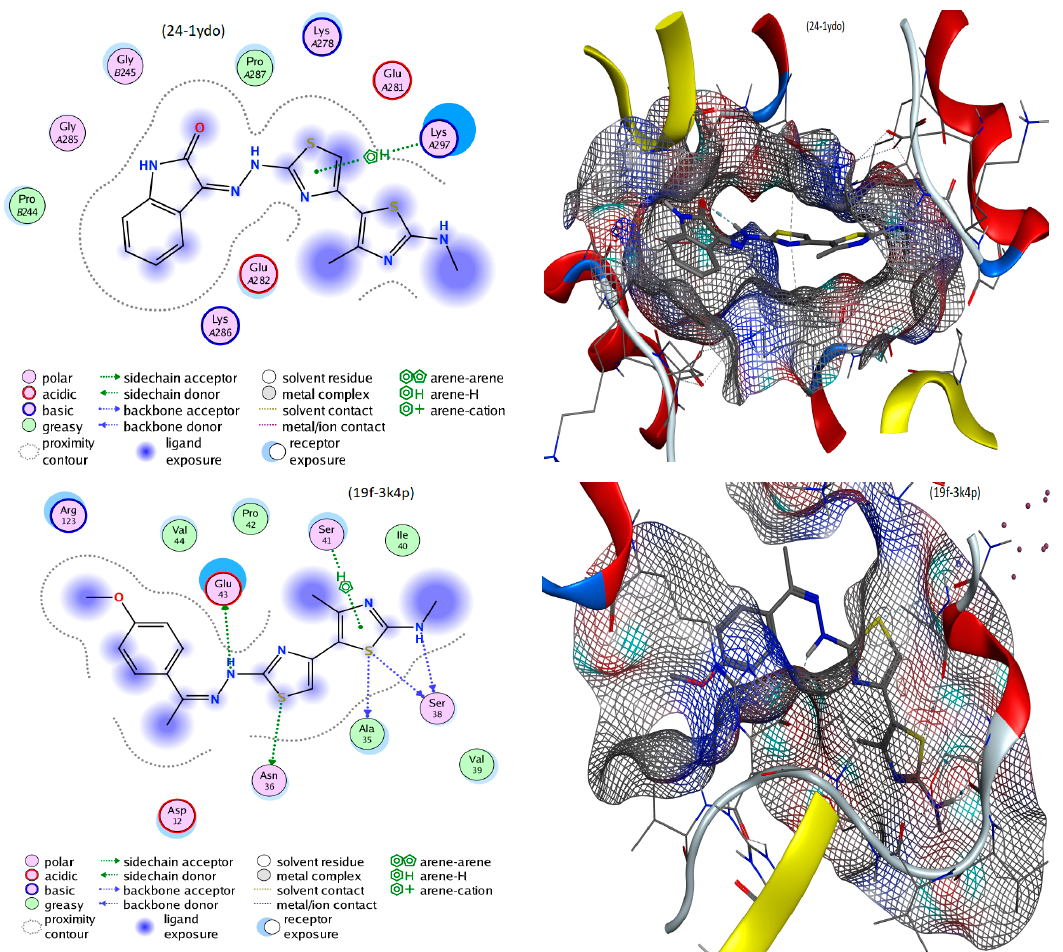
Figure 6. Best docking interaction ( A ) and surfaces maps ( B ) of selected compounds. Figure 5. Best docking interaction ( A ) and surfaces maps ( B ) of selected